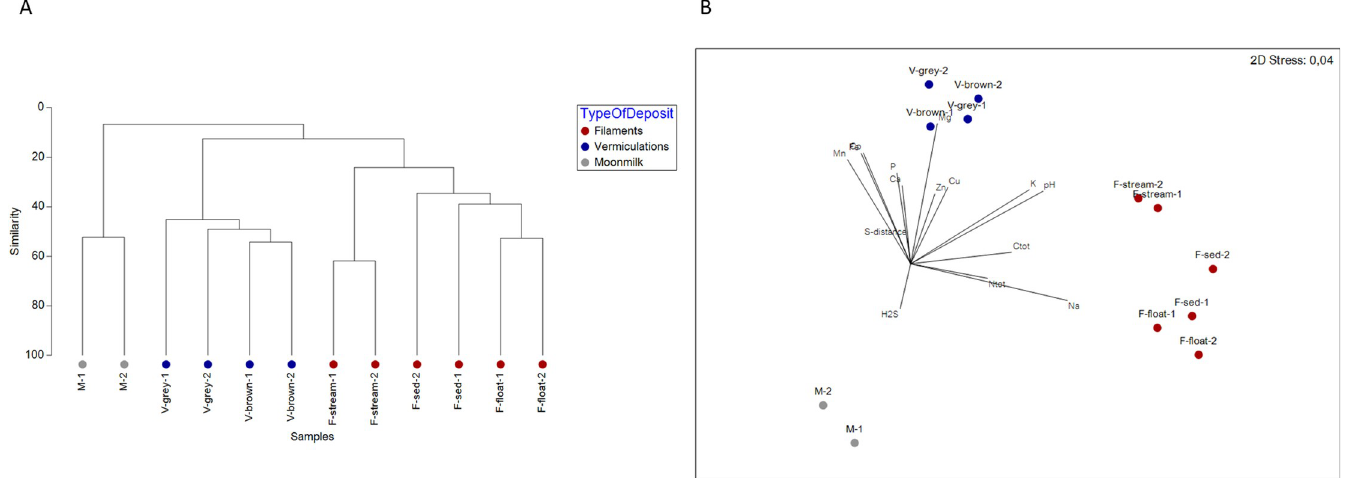
Fig 5. Clustering of the different biofilm samples from Fetida Cave Cluster. A) Clustering calculated using the Bray-Curtis distance between samples based on SV taxonomy classification in SILVA. B) Non-metric multidimensional scaling (nMDS) showing correlation between physico-chemical factors and biofilm microbial community composition. Water filaments are represented in red, vermiculations in blue, and moonmilk deposits in grey.